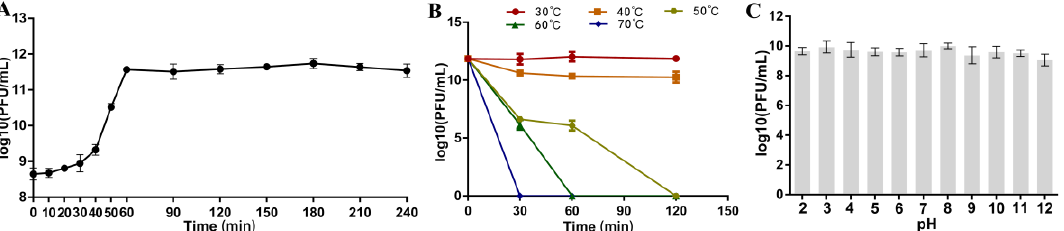
Figure 3. The one-step growth curve under the MOI of 0.1 and the results of the temperature stability and pH stability test of Aeromonas phage Ahy-yong1. ( A ) The one-step growth curve demonstrated that the latent period of Aeromonas phage Ahy-yong1 was 10 min, followed by a burst period of 50 min. ( B ) Aeromonas phage Ahy-yong1 was very stable at 30 ◦ C, maintaining constant production for over 120 min; relatively stable at 40 ◦ C; not stable at 50 ◦ C, 60 ◦ C, and 70 ◦ C. Phage Ahy-yong1 eventually became inactive when the temperature exceeded 50 ◦ C. ( C ) Aeromonas phage Ahy-yong1 was found to be stable at pH 2 to 12, indicating that even extremes of pH could not affect infectivity of phage Ahy-yong1. All values represent the mean of triplicate measurements, and error bars represent the standard deviations ( n =